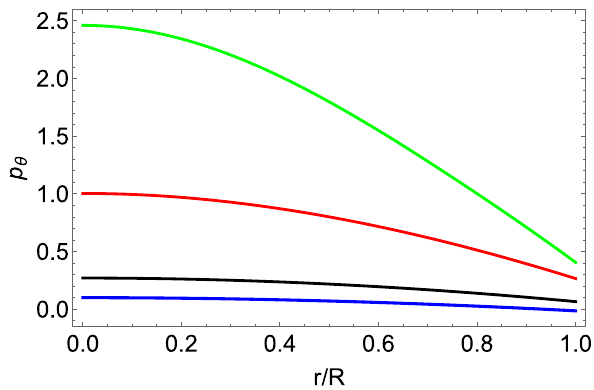
Fig. 11 p θ for u = 0 . 16 (blue line), u = 0 . 2 (black line), u = 0 . 3 (red line), u = 0 . 37 (green line) and (cid:13) =